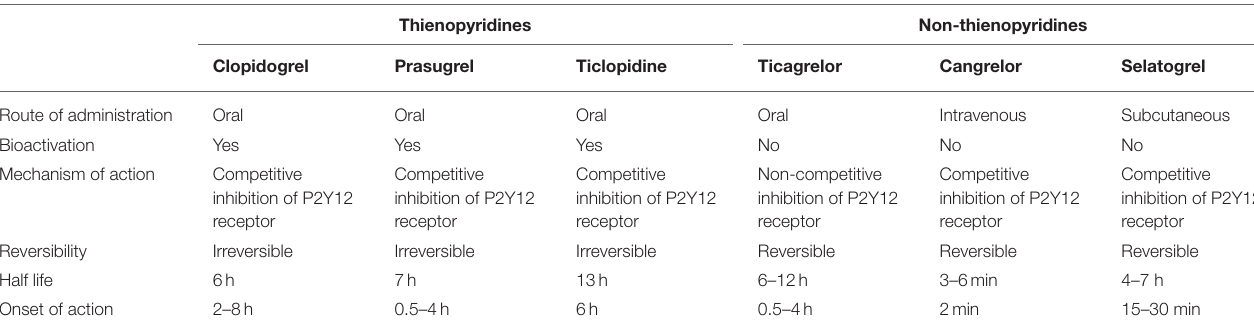
TABLE 1 | Overview of the P2Y12